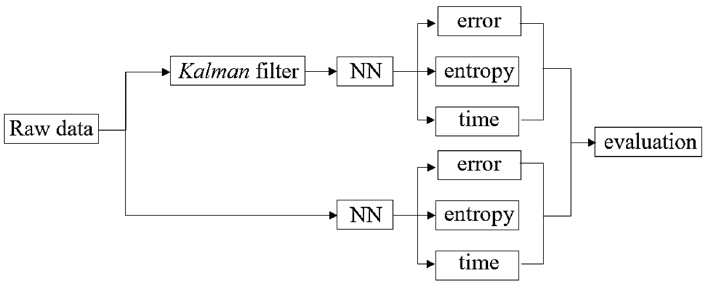
Figure 6. Estimation of the effectiveness of the ACKF.